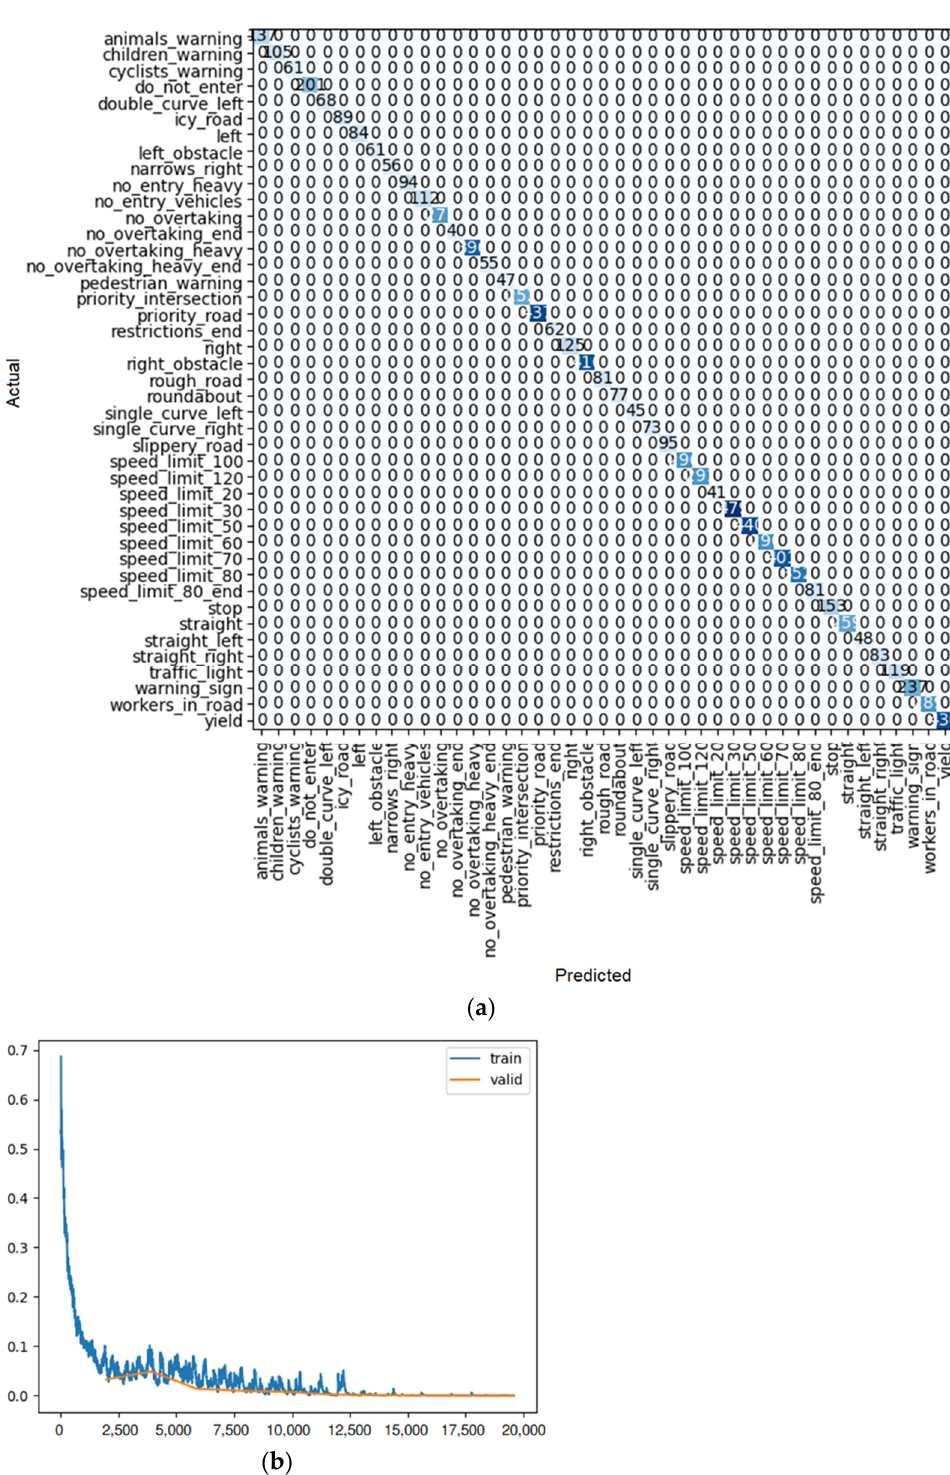
Figure 16. ( a ) Confusion matrix and ( b ) loss rate during training with VGG19_bn.